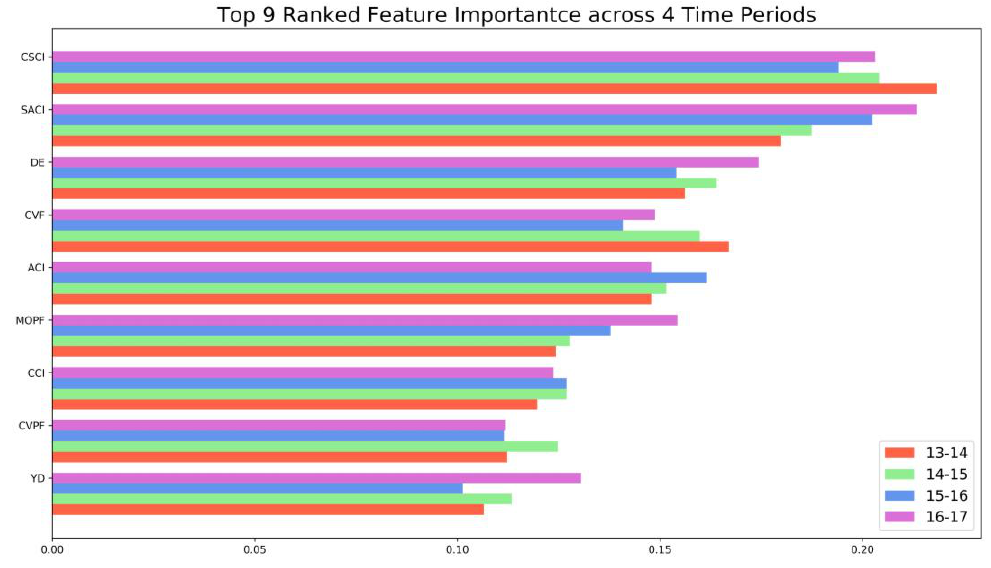
Figure 7. Feature importance (Gini index).